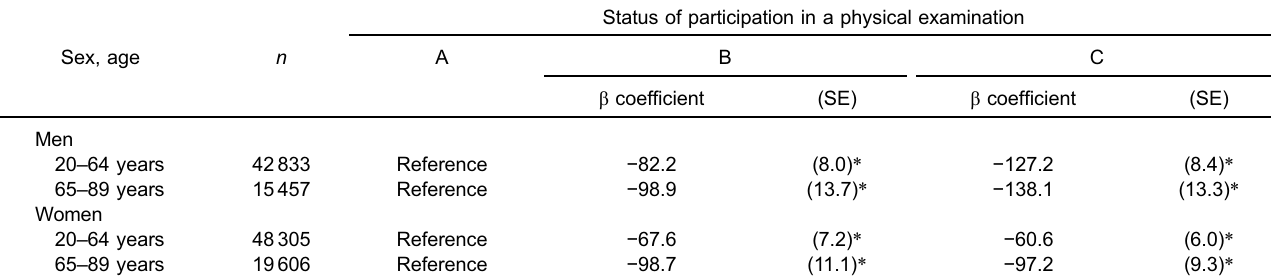
Table 4. Regression coef fi cients of total daily energy intake on the status of participation in a physical examination, by age group and sex, using the pooled data of National Nutrition Surveys 1997 – 2002 and National Health and